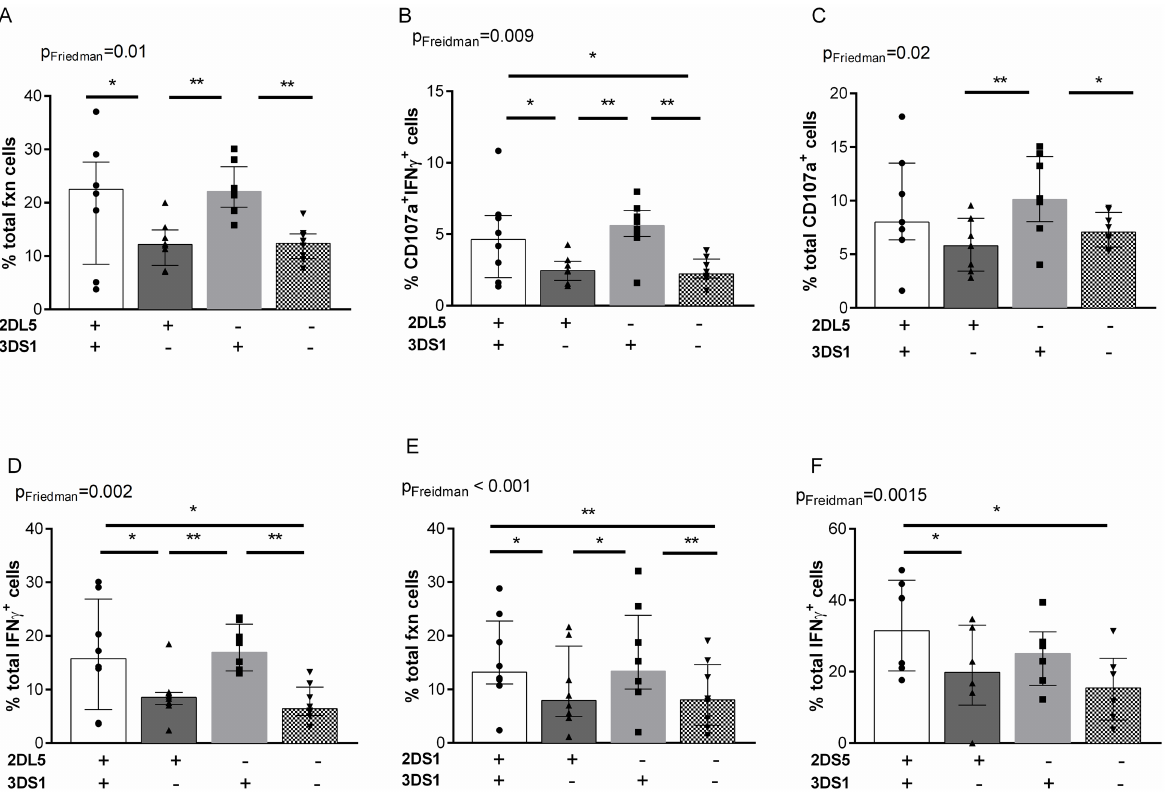
Fig 5. The frequency functional NK cells expressing all possible combinations of KIR3DS1and KIR2DL5, KIR3DS1and KIR2DS1and KIR3DS1and KIR2DS5responding to stimulation with 721.221(221) HLA null cells. Shownin the y-axis are the frequencies of NK cells expressing(A-D) all possiblecombinations of KIR3DS1 (3DS1) and KIR2DL5 (2DL5)(E) 3DS1 and KIR2DS1 (2DS1) and (F) 3DS1 and KIR2DS5 (2DS5) that respondedto stimulationwith 221 cells. (A, E) Frequency of all functionalNK cells (% total fxn cells), (B) NK cells secretingboth IFN- γ and CD107a, (% CD017a+IFN- γ + cells), (C) all NK cells expressingCD107a (% total CD107a+cells) (D, F), and all NK cells secretingIFN- γ (% total IFN- γ cells). Each point represents results from an individual subject. Bar heightsand error bars represent the median and inter-quartilerange of each group. Lines linking2 bars show comparisons betweenthe groups linkedby the lines. * = p < 0.05, ** = p < 0.01.